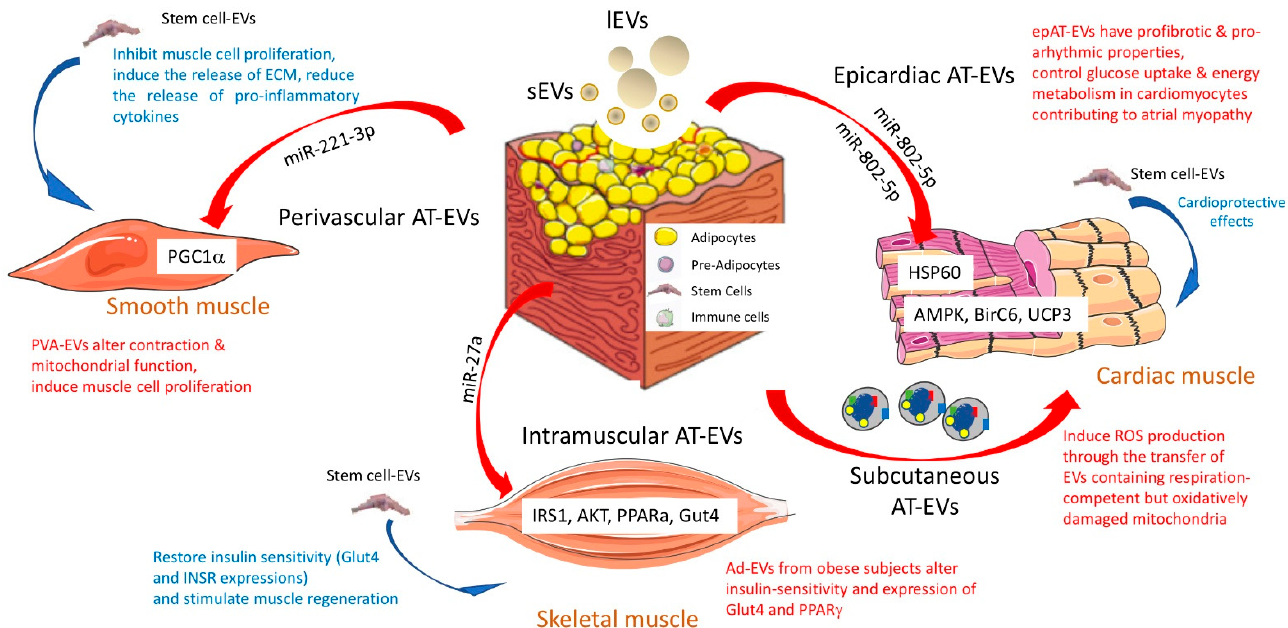
Figure 2. Biological functions of adipose tissue ‐ derived extracellular vesicles on the three different muscle cells (cardiac muscle, smooth muscle, and skeletal muscle) in pathological contexts (red). In blue, the specific functions of stem cell ‐ EVs are highlighted. For each type of adipose tissue, the role of miRNAs contained in EVs is indicated, and their target genes are mentioned in the muscle tissue. AT = adipose tissue; EVs = extracellular vesicles; ECM = extracellular matrix; sEV = small EVs with exosome ‐ like properties; lEV = large EVs from the budding of the plasma membrane [29].